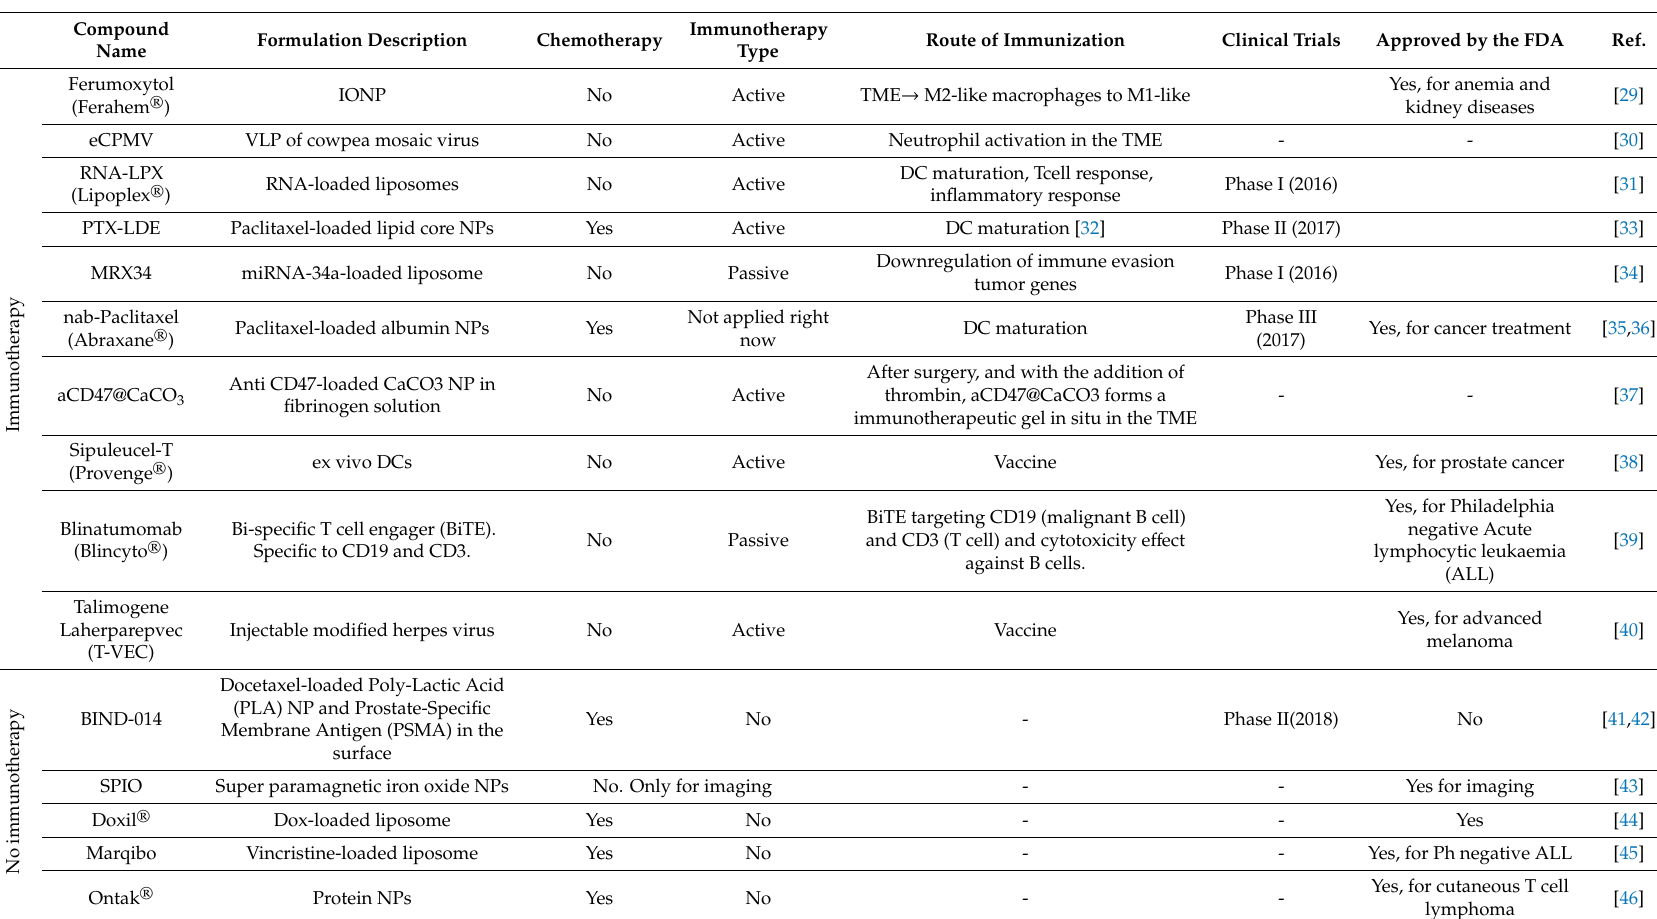
Table 1. Recently studied nanoformulations for immunotherapy. Some nano-formulations are approved by Food and Drug Administration (FDA) and others are in clinical trials